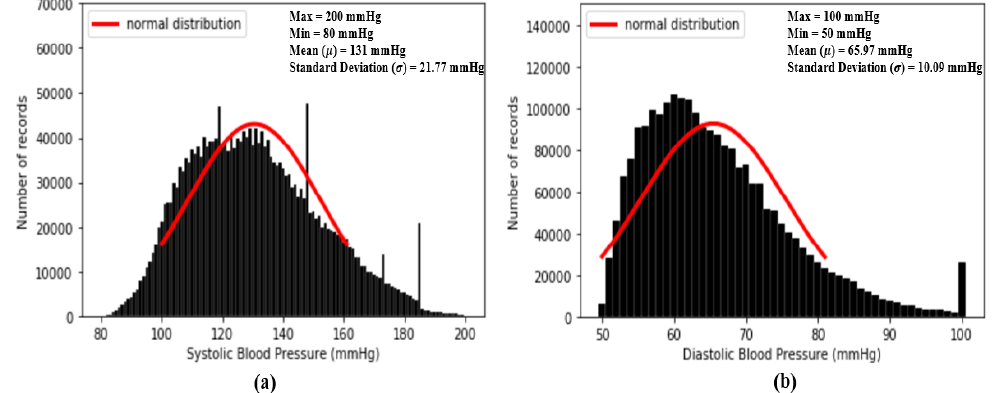
Figure 5. Histograms of distribution of blood pressure; ( a ) distribution of systolic blood pressure (SBP) ( b ) distribution of diastolic blood pressure (DBP).